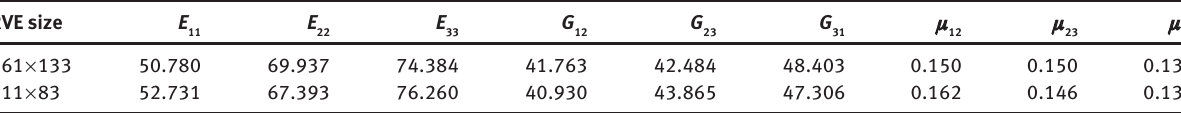
Table 6: Comparison of predicted elastic parameters with different RVE sizes. RVE